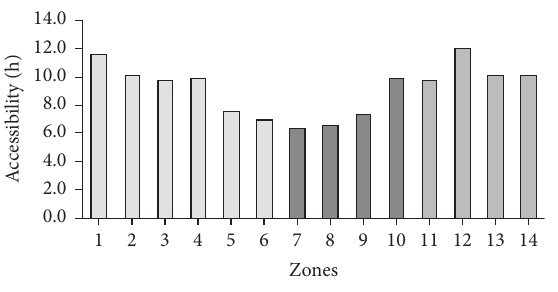
Figure 9: Active accessibility.